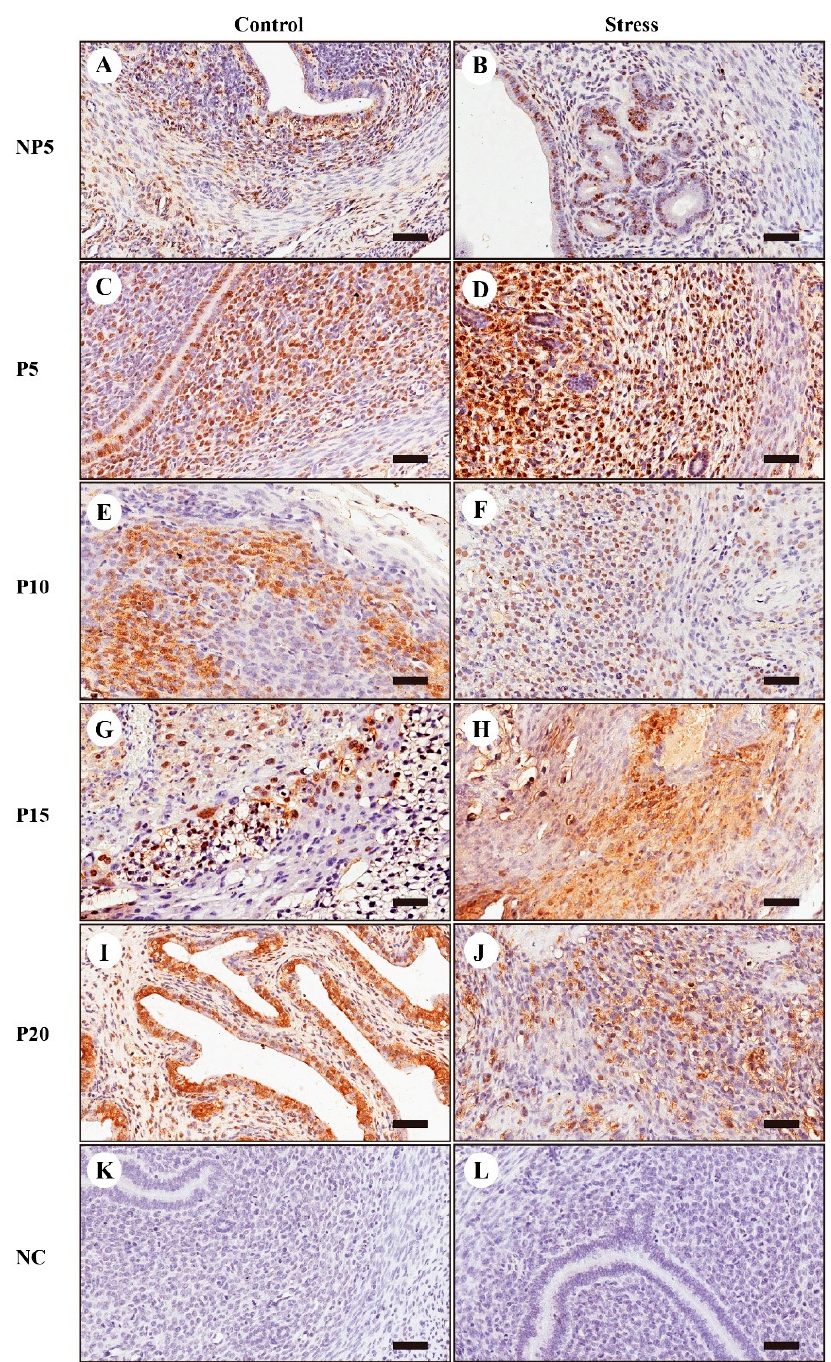
Figure 7. Immunohistochemical localization of FOXO1. To detect FOXO1 expression in the uterus, immunohistochemical localization was performed. A large number of positive cells were expressed in endometrial stromal cells of the uterus at NP5 ( A , B ), P5 ( C , D ), P10 ( E , F ), P15 ( G , H ), and P20 ( I , J ). The negative control (NC) were K (Control group) and L (Stress group). The yellow particles indicate positive cells. The scale bar is 50 μ m.